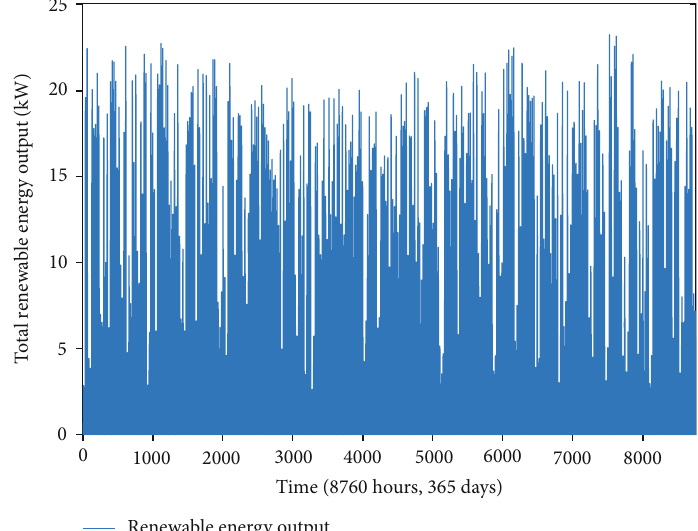
Figure 27: Total renewable output power of grid-PV system.